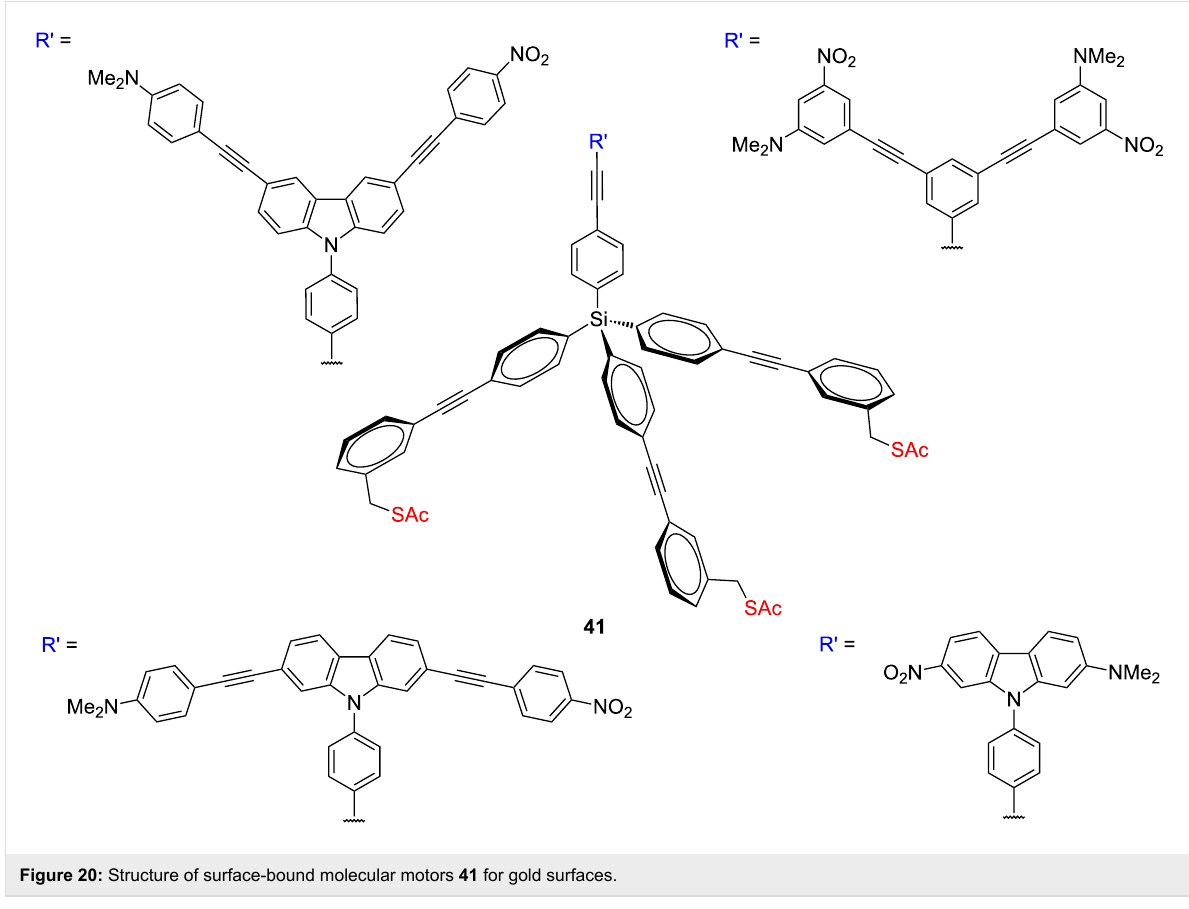
Figure 20: Structure of surface-bound molecular motors 41 for gold surfaces.